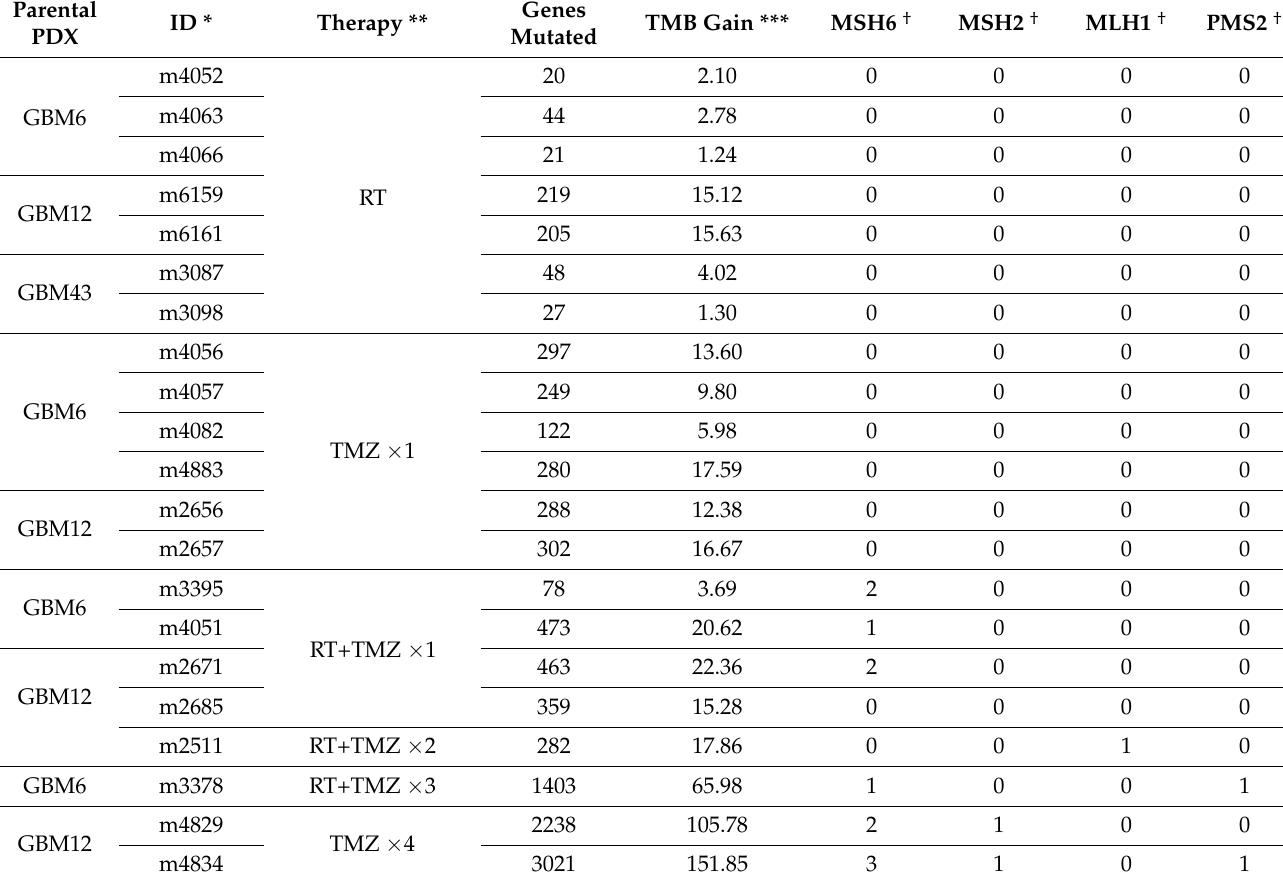
Table 1. Summary of Parental PDX and Derivative PDX Therapy and